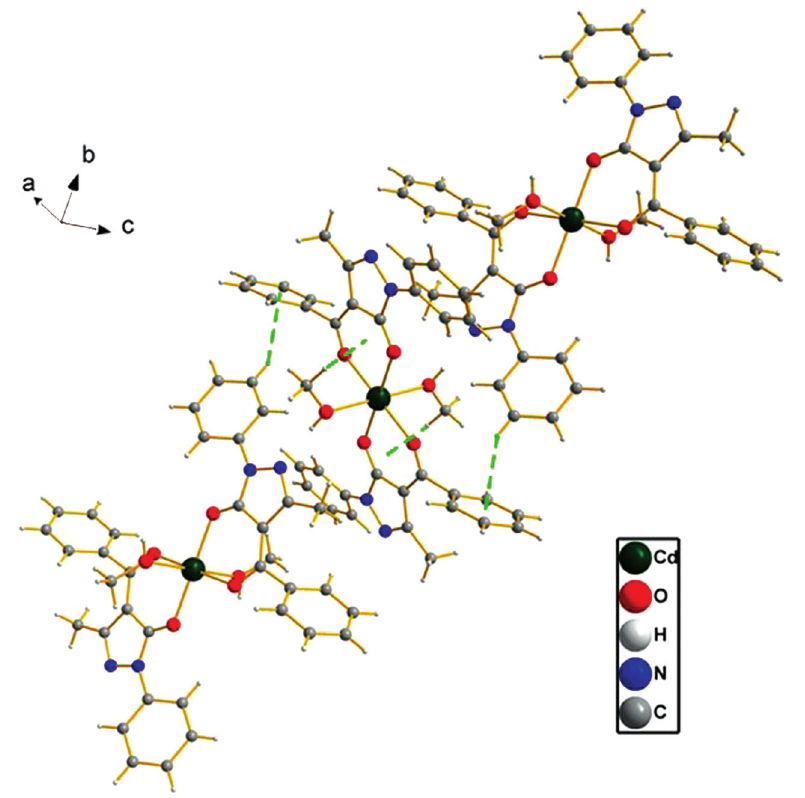
Figure 3: C-H··· π interactions of the title complex.